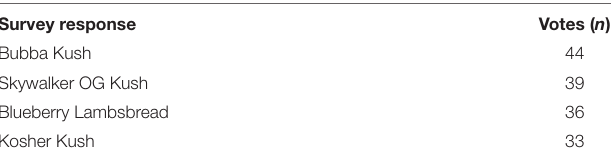
TABLE 2 | Strain(s) or product(s) most effective for treating anxiety for survey participants. Survey response